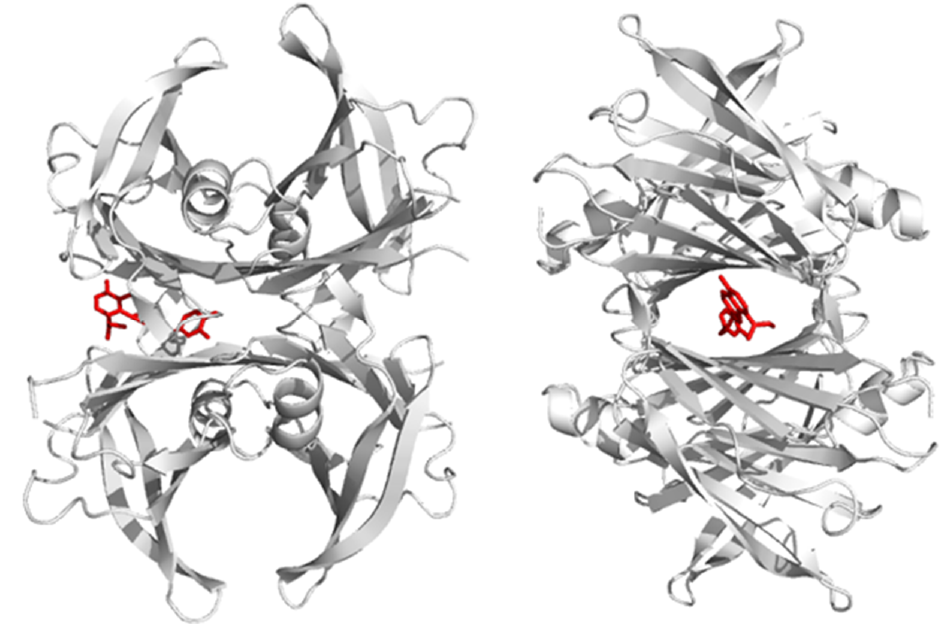
Figure 1. Orthogonal side views of the TTR tetramer binding OleA in the best (most stable) pose, as determined by molecular docking experiments performed with